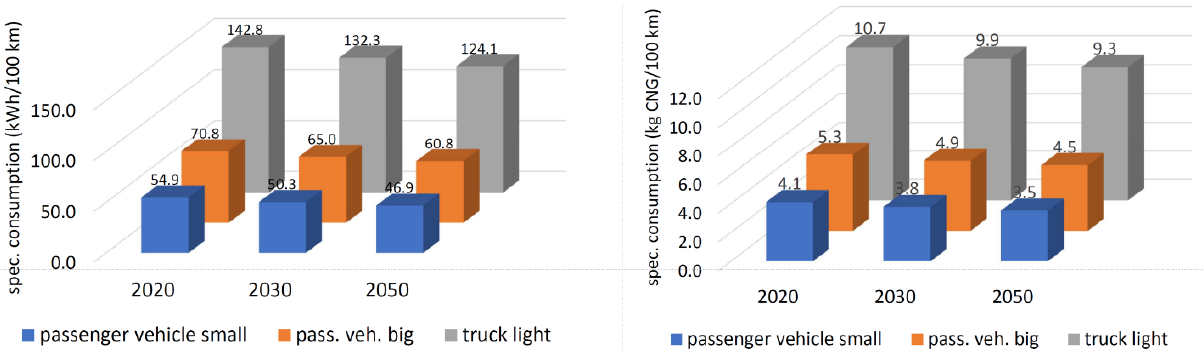
Figure 12. Specific consumption of FCEVs until 2050 (in kWh/100 km and kg/100 km).